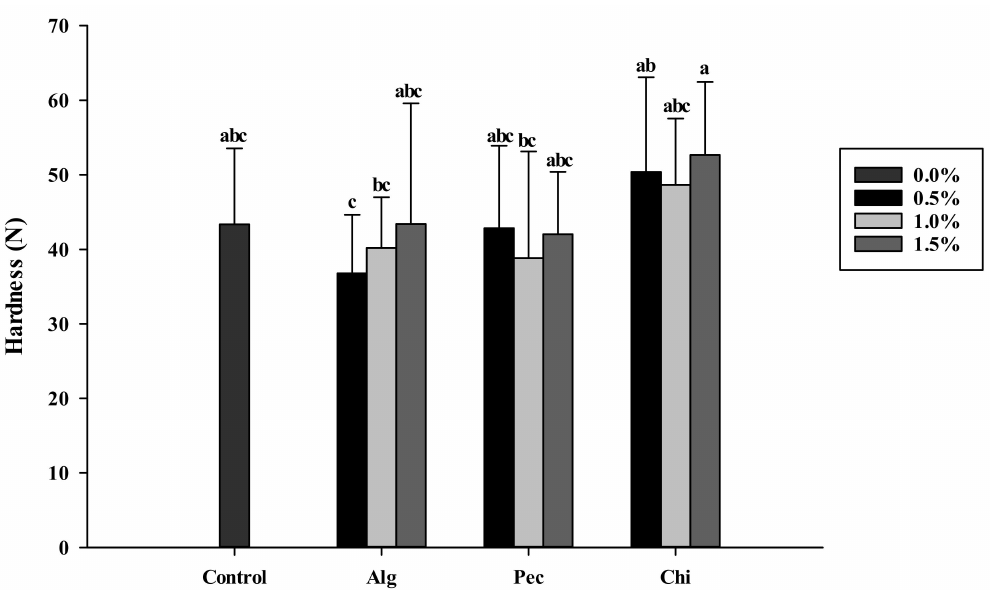
Figure 4. Hardness of biscuits added of sodium alginate, pectin and chitosan in different concen- trations. a, b, c: indicate statistically significant difference ( p < 0.05) among treatments ( n = 3). Alg: Sodium alginate; Pec: Pectin; Chi: Chitosan.